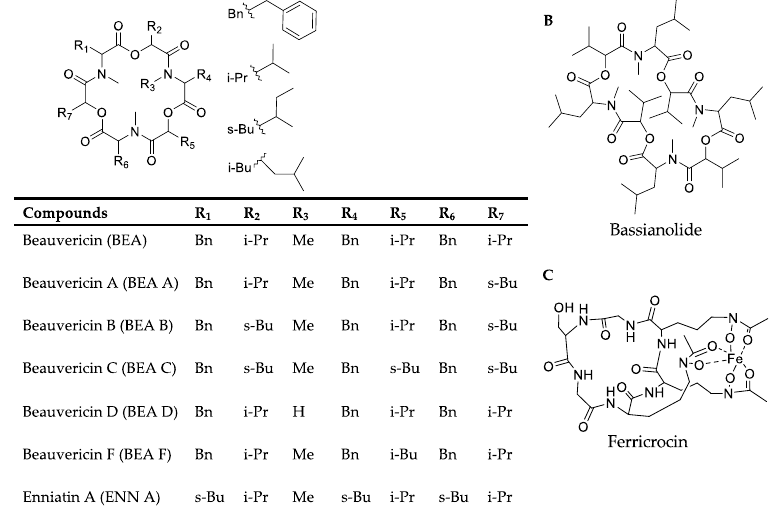
Figure 3. Chemical structures of ( A ) the beauvericins analyzed in this study (BEAs), enniatin A ( ENN A ) , ( B ) bassianolide ( BAS ) , and ( C ) ferricrocin ( FER ) . 3.3. Insect Virulence Factors Were Found Mainly for OEpks14 in Culture Positive ion data of the OE pks14 and ∆ pks14 strains in culture media were compared to assess differences in metabolite profiles . Six insect-virulence compounds and one siderophore were mainly produced in OE pks14 , as opposed to ∆ pks14 . The three MFs of insect - virulence compounds were an MF of BEA ( m / z 784.4120, calcd. For C 45 H 57 N 3 O 9 H + , Δ − 6 . 75 ppm ) and BEA A / F ( m / z 798 . 4277, calcd. For C 46 H 59 N 3 O 9 H + , Δ − 6 . 89 ppm ) , an MF of BAS ( m / z 909.6098, calcd. For C 48 H 84 N 4 O 12 H + , Δ − 7 . 26 ppm ) , and an MF of ENN A ( m / z 682.4590, calcd. For C 36 H 63 N 3 O 9 H + , Δ − 7 . 76 ppm ) ( Figure 4A ). BEA A and BEA F have similar chemical formulas and molecular weights but are different in structure . BEA A contains a secondary butyl ( s - Bu ) group of isoleucine ( Ile ) at R 7 instead of the isopropyl ( i - Pr ) group of valine ( Val ) in BEA F (Figure 3) . Ile and Val have similar molecular weights, and their MS / MS spectra cannot be distinguished; therefore, m / z 798 . 4277 [ M + H ] + could be BEA A or BEA F . Two singletons of insect-virulence compounds represented BEA B ( m / z 812.4425, calcd. for C 47 H 61 N 3 O 9 H + , Δ − 7 . 50 ppm ) and BEA C ( m / z 848.4398, calcd. for C 48 H 63 N 3 O 9 Na + , Δ − 7 . 54 ppm ). One siderophore MF was FER ( m / z 771 . 2446, calcd. for C 28 H 44 FeN 9 O 13 H + , Δ − 5 . 19 ppm ) ( Figure 4A ). ENN A was uniquely found in OE pks14 and not in ∆ pks14 . BEA, BEA A, BEA B, BEA C, and BAS were increased in OE pks14 compared to ∆ pks14 , and there was no difference for FER ( Figures 4A and S5 ). MS / MS spectrum annotation of classified metabolites was performed based on their fragmentation pattern ( Figure S6 ) . MF and singleton metabolites of interest are summarized in Table 1 .